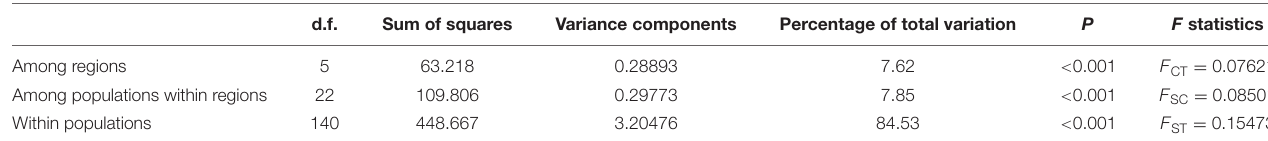
TABLE 3 | Analysis of molecular variance (AMOVA) for Mikania micrantha populations from six introduced regions in southern China. d.f. Sum of squares Variance components Percentage of total variation P F